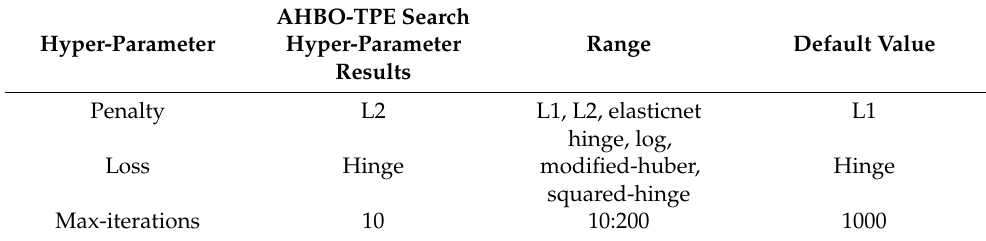
Table 9. SGD Model AHBO-TPE Search Hyper-parameter Results (Ember Dataset).